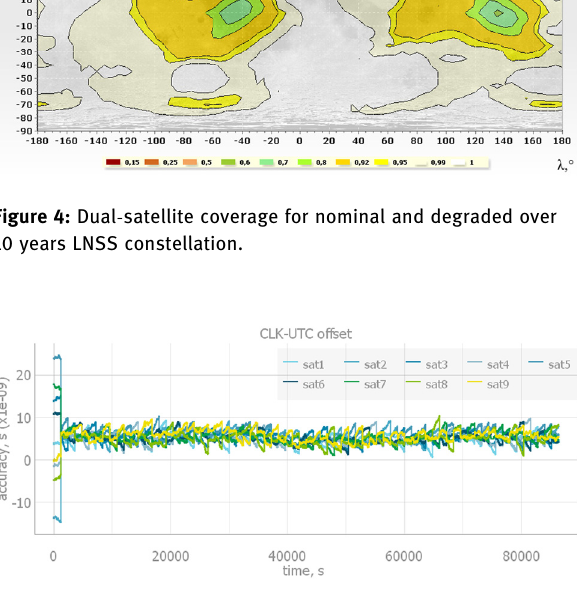
Figure 5: OGTS generation results as the o ff set between broadcast clocks and